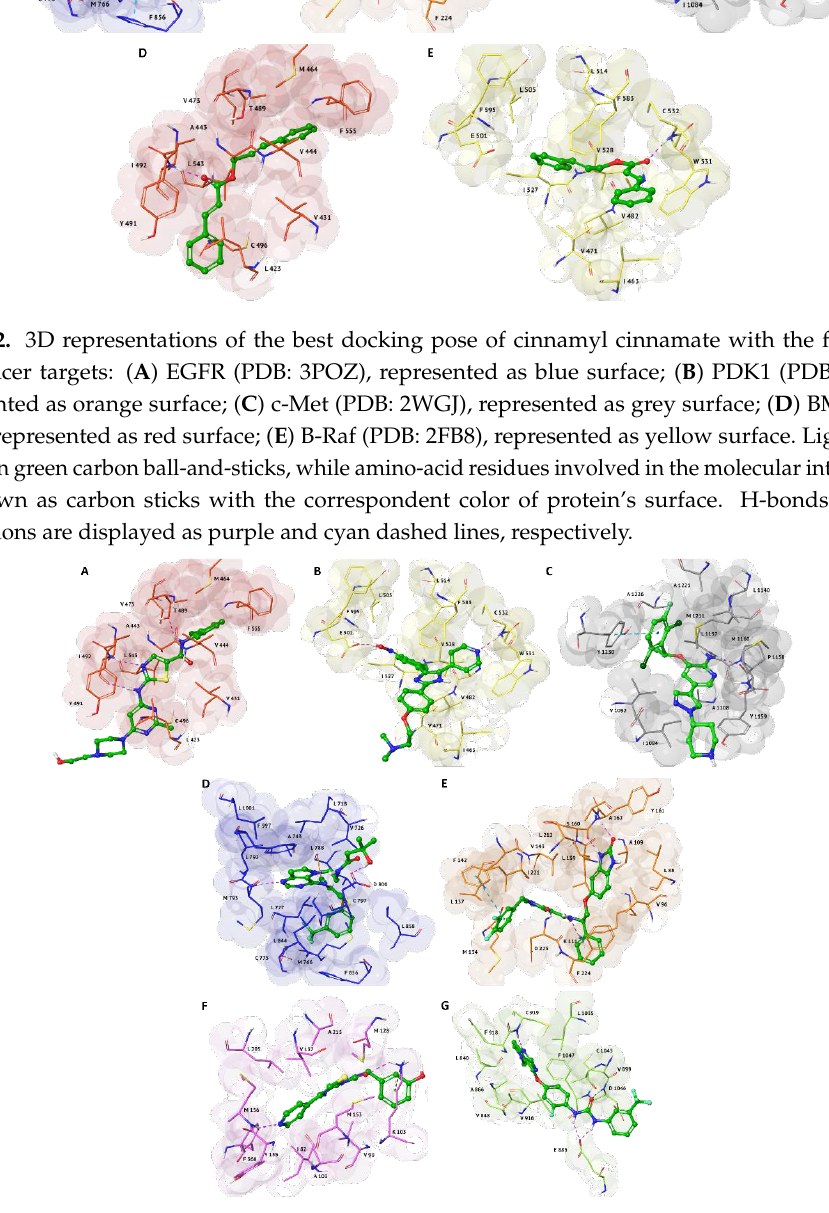
Figure 3 . Re-docked best poses of the relative co-crystallized ligands in the Protein Data Bank (PDB) models: ( A ) BMX (PDB code: 3SXR), represented as red surface; ( B ) B-Raf (PDB code: 2FB8), represented as yellow surface; ( C ) c-Met (PDB code: 2WGJ), represented as grey surface; ( D ) EGFR (PDB code: 3POZ), represented as blue surface; ( E ) PDK1 (PDB code: 3NAX), represented as orange surface; ( F ) ROCK1 (PDB code: 3TWJ), represented as pink surface; ( G ) VEGFR2 (PDB code: 3VHE), represented as green surface. Ligands are shown in green carbon ball-and-sticks, while amino-acid residues involved in the molecular interactions are shown as carbon sticks with the correspondent color of protein’s surface. H-bonds, π - π and halogen interactions are displayed as purple, cyan and yellow-gold dashed lines,